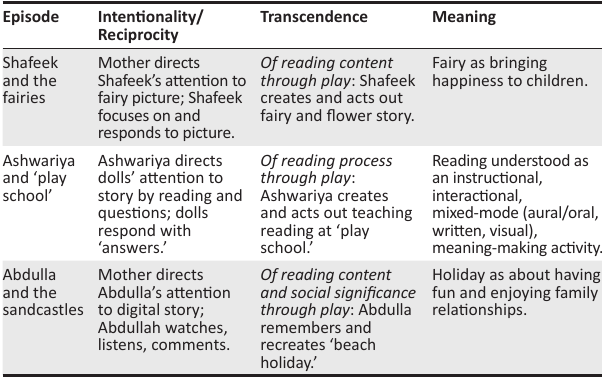
TABLE 1: Mediated learning, early reading and play.